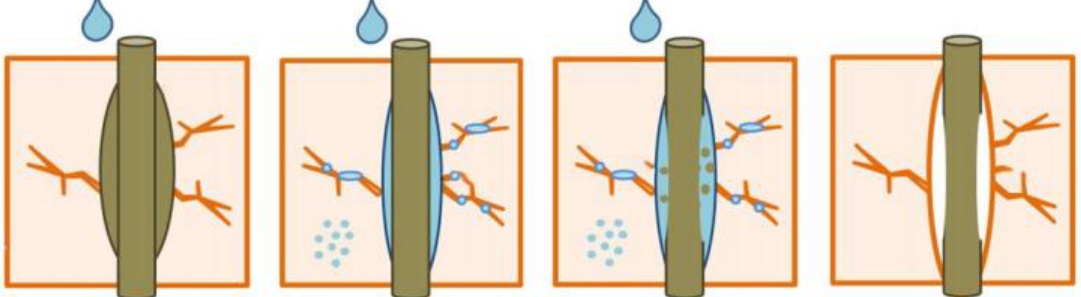
Figure 1. Degradation of composite interface due to moisture absorption (Adapted from the refer- ence